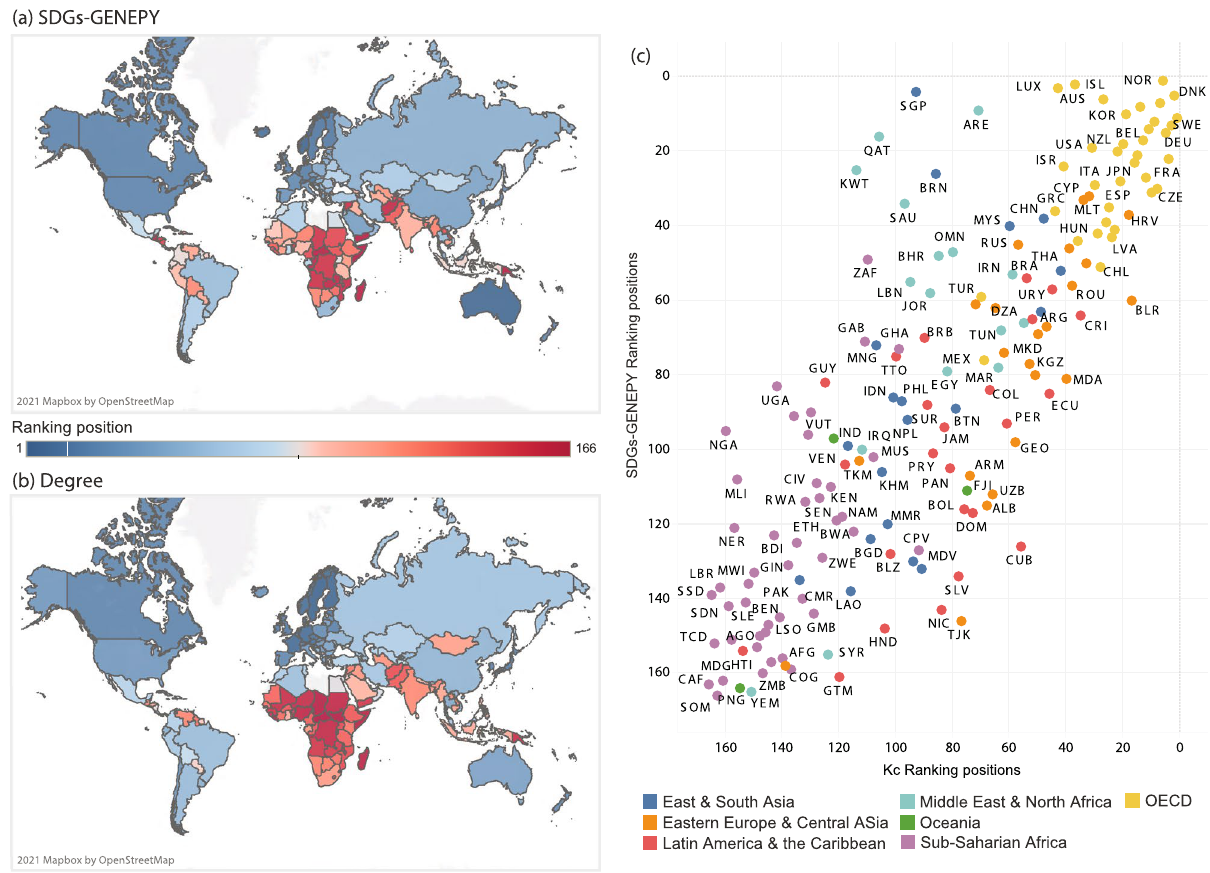
Figure 4. Countries rankings according to the degree and SDGs-GENEPY values . In panel ( a ), countries are coloured according to the ranking position computed by the SDGs-GENEPY score. Panel ( b ) shows the ranking position computed by the degree or, equivalently, the SDG Index 26 . The ranking position is defined in both maps according to descending score (1 = best performer, 166 = worst performer). In panel ( c ), we scatter the values of the two rankings: on the x-axis is the degree ranking, on the y-axis, the SDGs-GENEPY one. Countries are colour-coded according to their Region as specified in the legend, in accordance with the regional division in the 2020 Dashboard 26 . Countries lying along the diagonal share the same ranking position both in SDGs- GENEPY and SDG Index. The figure has been generated using Tableau 2020.3, [https:// www. table au. com/]; in panels ( a ) and ( b ), underlying maps are provided by OpenStreetMap, [https:// www. opens treet map.